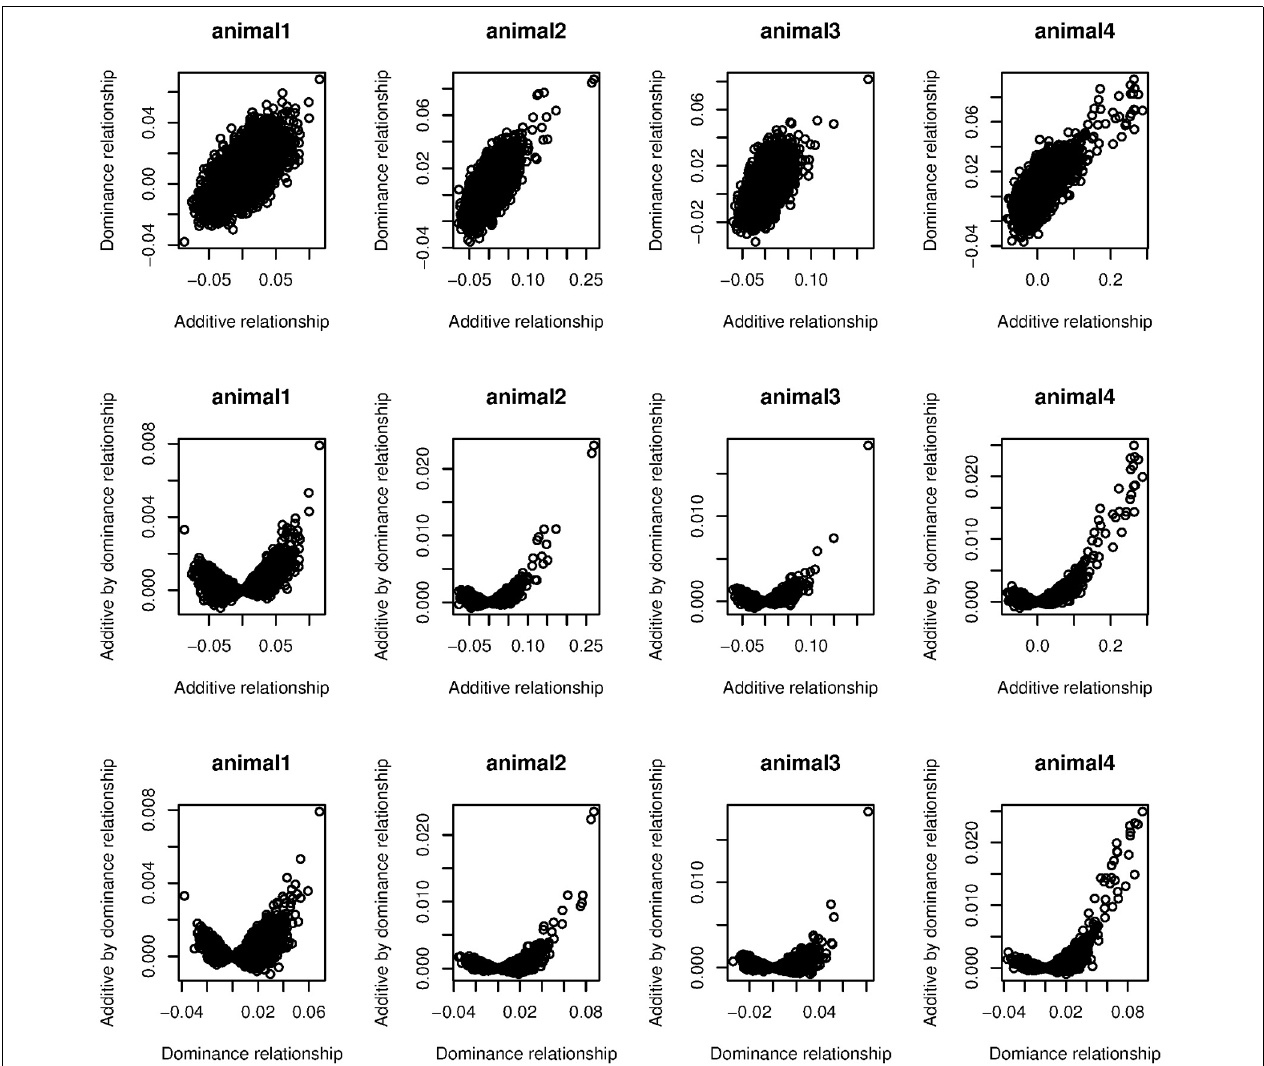
FIGURE 2 | Scatter plots of relationships among additive (G), dominance (D), and additive by dominance (GD) taken from four randomly sampled animals.